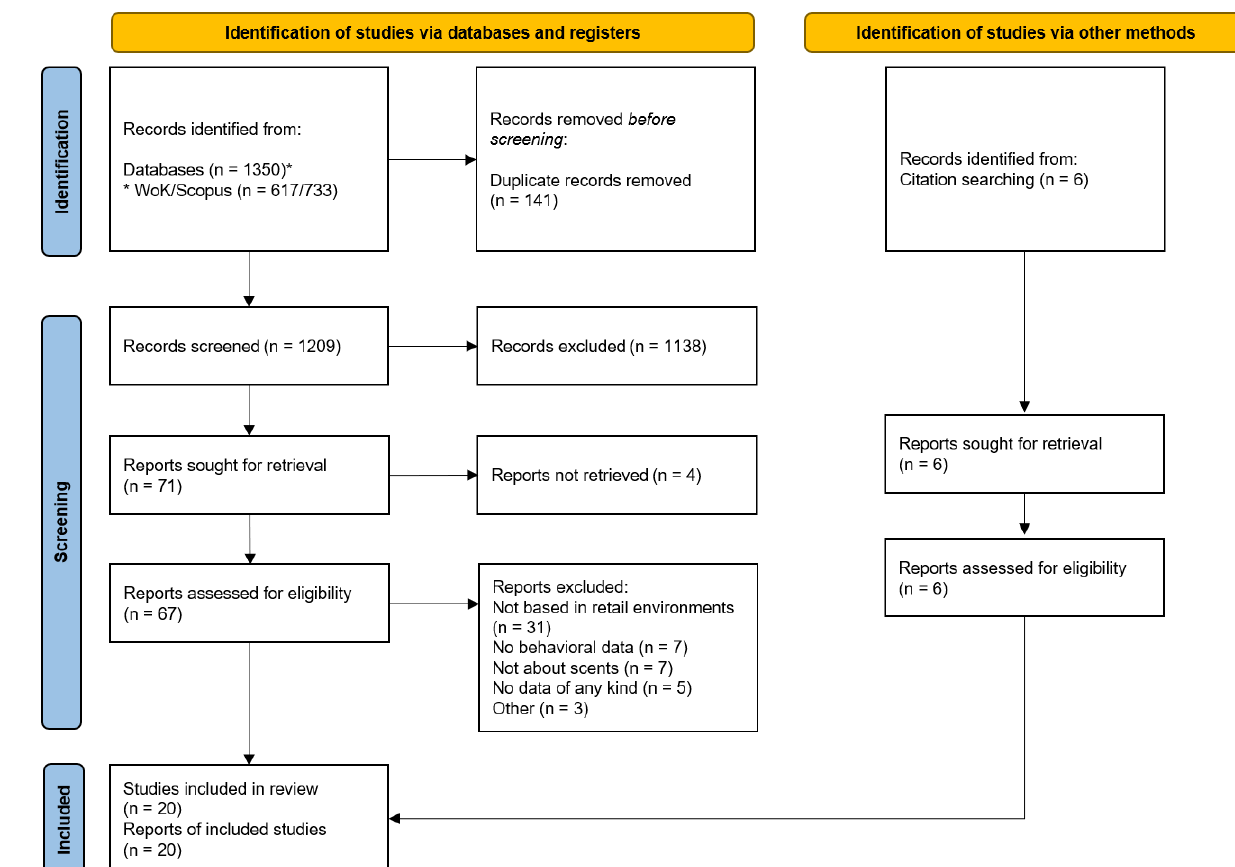
Figure 1. PRISMA flow diagram for the systematic review of aromachology and customer